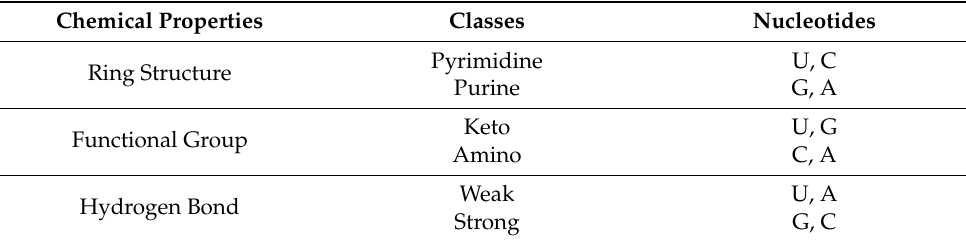
Table 6. Chemical properties of each nucleotide